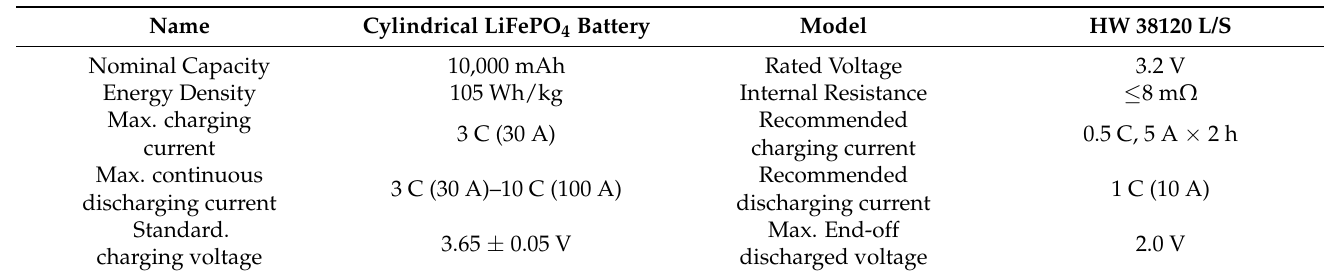
Table 1. Specification of LiFePO 4 HW 38120 L/S battery